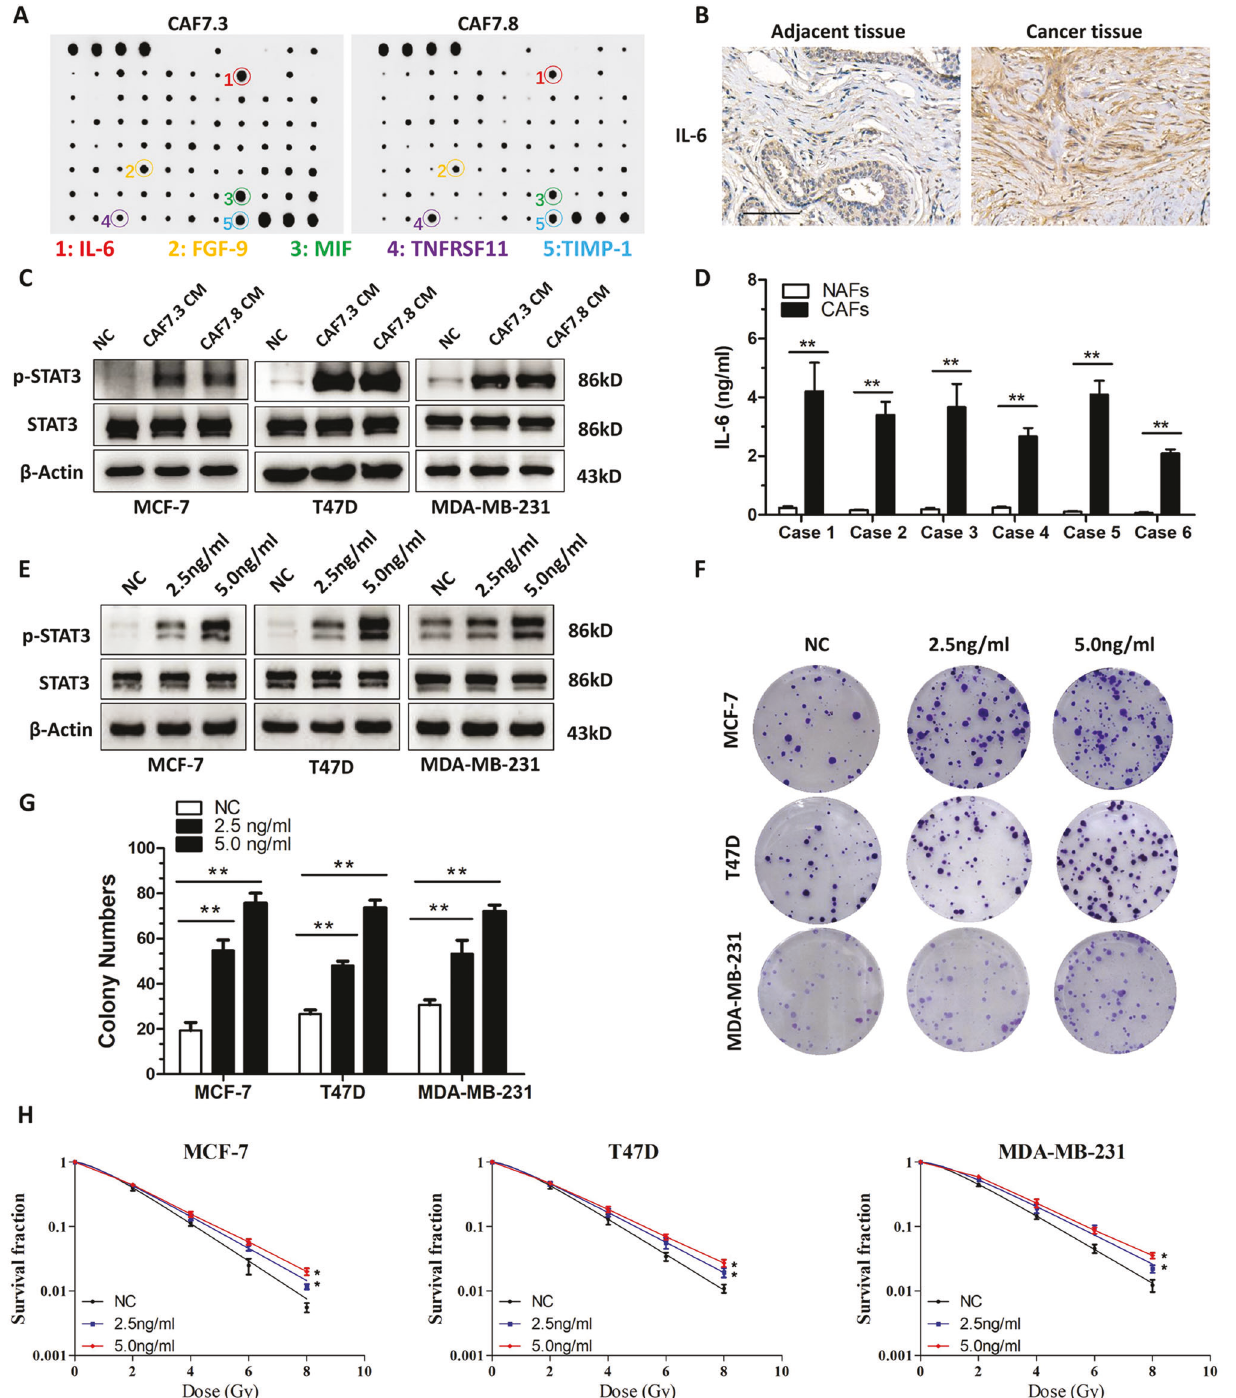
Fig. 3 CAFs secreted IL-6 to induce the growth and radioresistance of breast cancer cells. A Cytokine antibody array analysis of the growth factors secreted by CAFs. IL-6, FGF-9, MIF, TNFRSF11, and TIMP1 were secreted at high levels from CAFs. B The expression of IL-6 was detected via IHC in adjacent normal tissue and breast cancer tumor tissue. Scale bars, 100 μ m. C Western blotting analysis the p-STAT3 and STAT3 levels in T47D, MCF-7, and MDA-MB-231 cells. The cells were grown in CAF conditioned media for 12 h. D The concentration of IL-6 in conditioned media from paired normal tissue-associated fi broblasts (NAFs) and CAFs were analyzed by ELISA. E IL-6 was used to treat MDA-MB-231, MCF-7, and T47D cells for 6. The levels of STAT3 and p-STAT3 were analyzed using western blot. F , G Colony formation assay showing that IL-6 treatment increased the breast cancer cell colony numbers. H IL-6 treatment increased the survival fractions of breast cancer cells according to a clonogenic survival assay. The results are displayed as means ± SD, n = 3, * P < 0.05, ** P < 0.01.